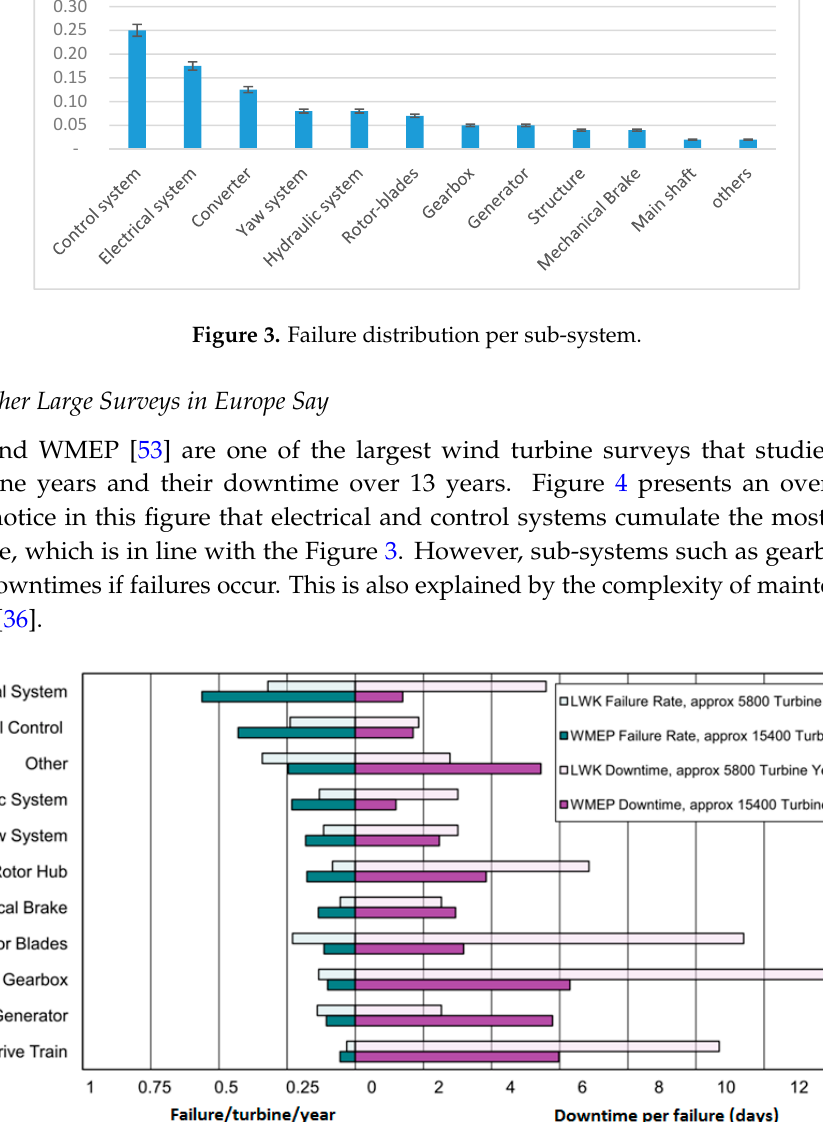
Figure 4. Failure per turbine per year and downtime from two large surveys of European onshore wind turbines over 13 years (LWK and WMEP).